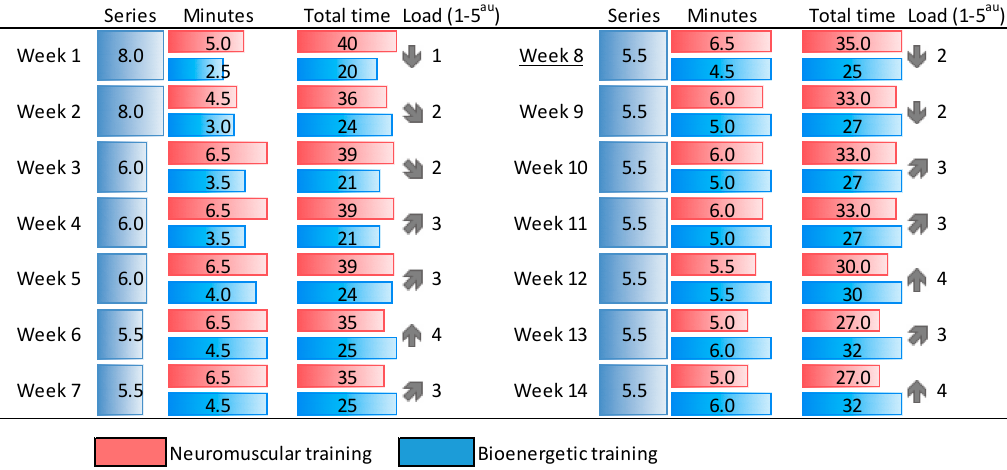
Figure 2. Multicomponent training program. Neuromuscular contents were prevalent in weeks 1 to 7, a trend inverted in weeks 9 to 14, when metabolic demands were increased after some controls in week 8. Load 1–5 au (arbitrary units) and the grey arrows in the column (formatted in excel) display the load undulation, where 5 would be the maximum exertion tolerated for the session.